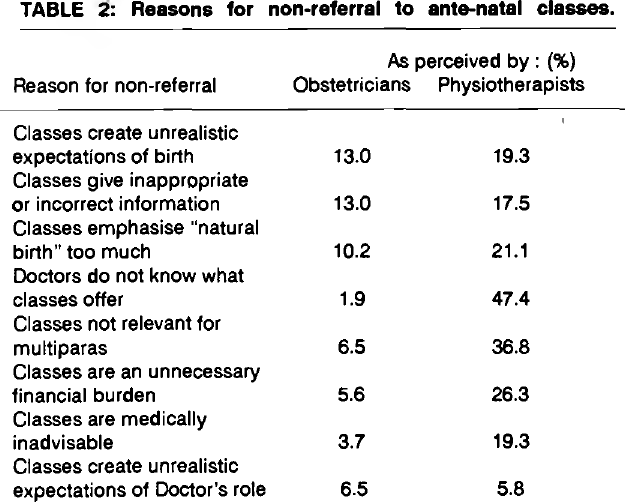
TABLE 2: Reasons for non-referral to ante-natal classes.